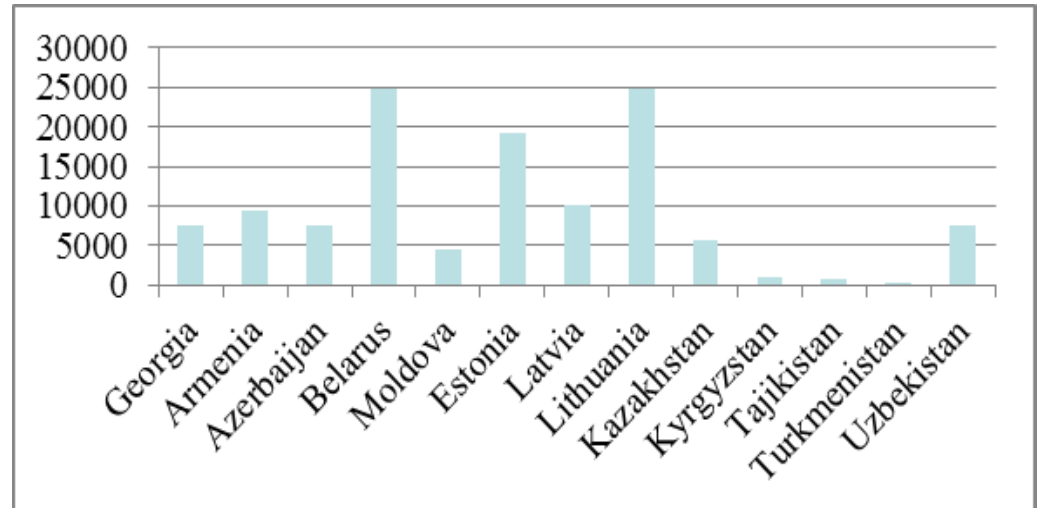
Figure 1. The total number of publications for 13 former Soviet Union countries for 1996-